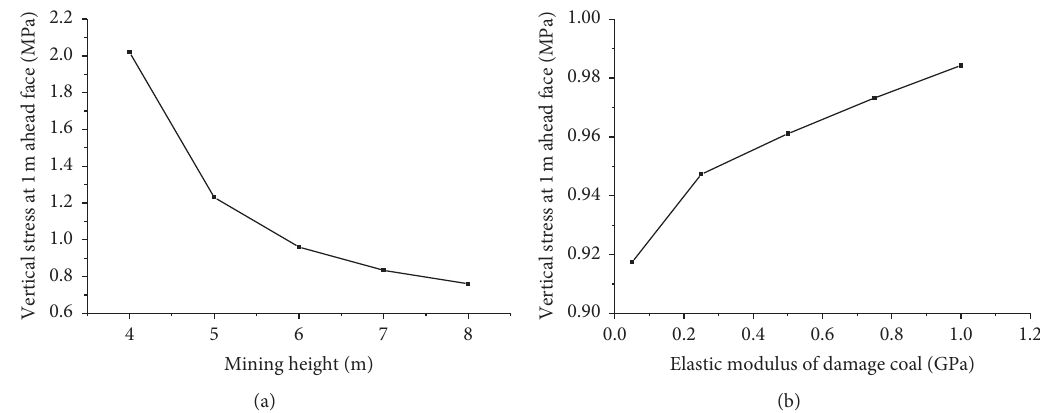
� 0.5GPa). (b) The influence of the elastic modulus of em